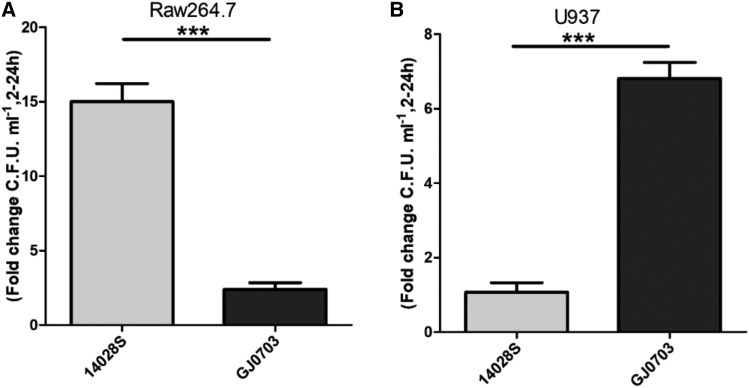
Evaluation of S. Rissen virulence in cell models. (A) Replication rates in RAW264.7 murine macrophage-like cells of strains 14028S and GJ0703. Salmonella enterica serovar Typhimurium 14028S and Rissen GJ0703 were grown with overnight shaking (250 rpm) in 5 ml LB medium at 37°C. RAW264.7 cells were infected at a multiplicity of infection of 10. Cells were lysed with 0.1% (v/v) Triton X-100 in phosphate-buffered saline (PBS) 2 and 24 h after infection. Lysates were diluted and plated on agar plates for bacterial colony counting. The replication rate was calculated as the fold change in bacteria recovered between 2 and 24 h after infection. (B) Replication rates in human macrophages U937 cells. For differentiation, U937 cells were stimulated with 30 nM phorbol myristate acetate for 2 d. The cells were infected at a MOI of 100, and the net growth between 2 and 24 h was calculated from the fold change in bacteria recovered at these time points. Error bars represent standard deviations from 3 independent experiments. ***, P < 0.001, (analysis of variance). Abbreviations: CFU, colony-forming unit; Lg, denary logarithm, or the base-10 logarithm; PBS, phosphate-buffered saline.